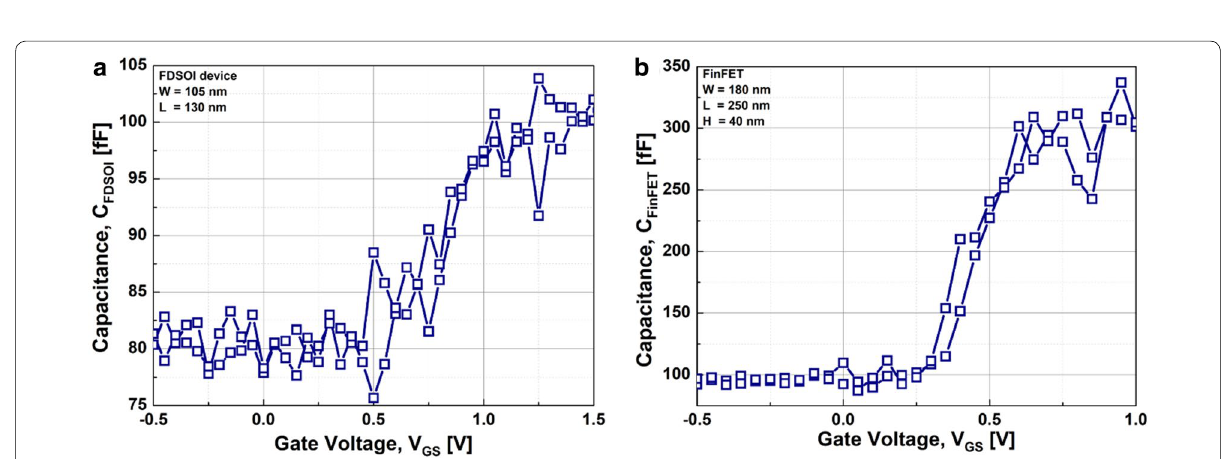
Fig. 3 Measured capacitance vs. gate voltage of baseline a FDSOI device, b